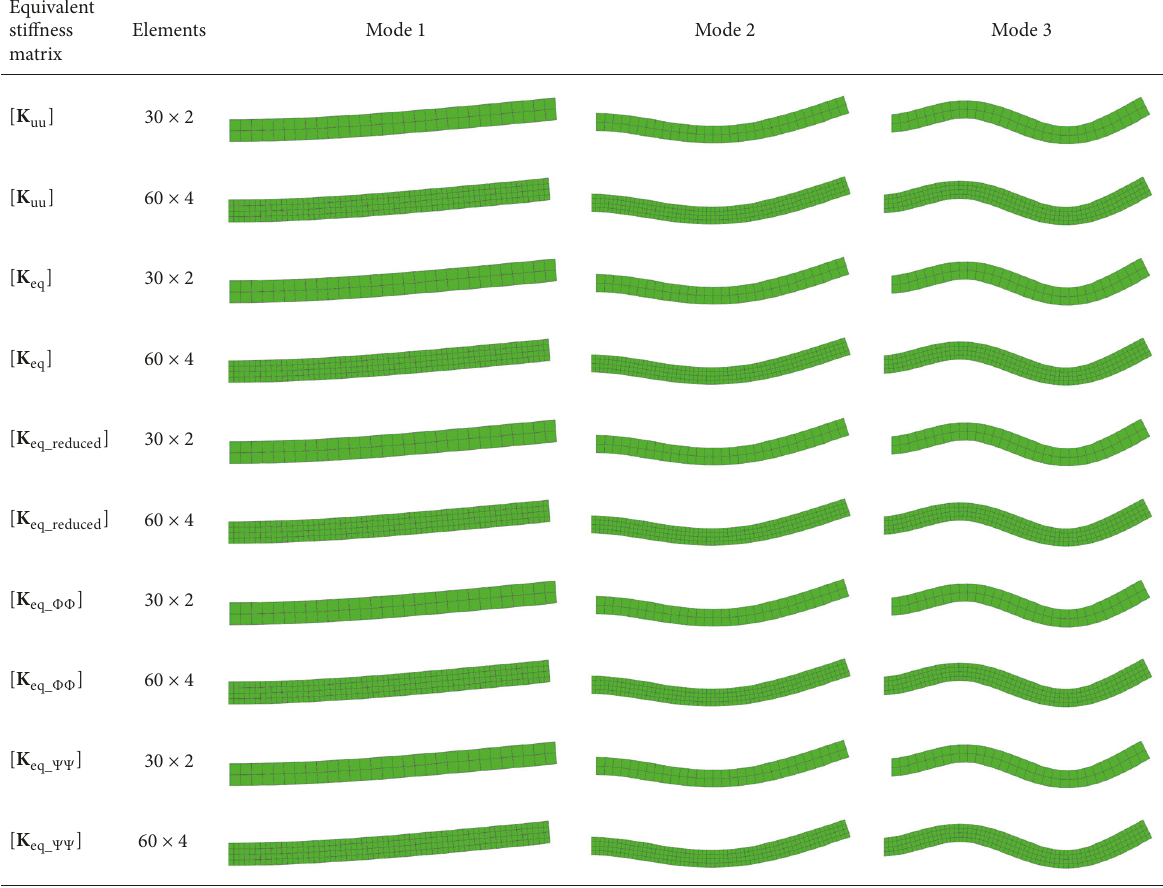
Figure 6: The first- to third-order modes of clamp-free BaTiO 3 –CoFe 2 O 4 FGMEE beams using different elements with exponential factor 𝜂 = 1.0 by